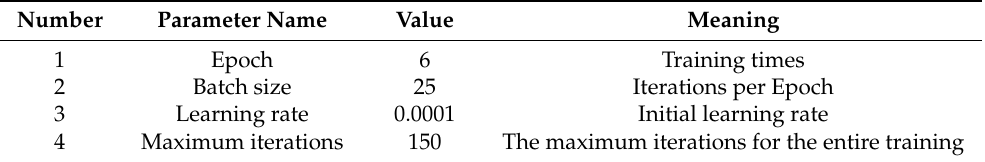
Figure 6. The waveform of the Swish activation function when the parameter β takes different values.